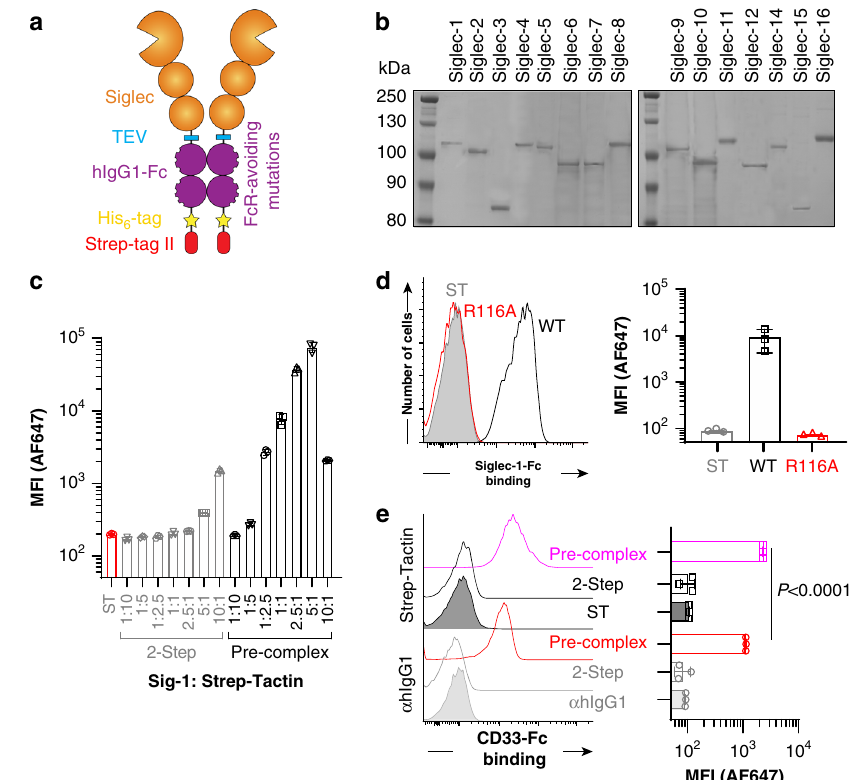
Fig. 1 Production and validation of new Siglec-Fc proteins. a Depiction of molecular features built into the new Siglec-Fc construct. b Coomassie-stained SDS-PAGE gel of all Siglecs puri fi ed through a three-step Nickel, ST, and SEC column puri fi cation strategy. Results are representative of two independent sets of puri fi cations. c Different amounts of puri fi ed Siglec-1-Fc was incubated with U937 cells in either a two-step or a pre-complexed approach with a constant amount of Strep-Tactin-AF647. d Flow cytometry results for probing Siglec-1-Fc WT or Siglec-1-Fc R116A with U937 cells using the optimized pre-complexed conditions. e Flow cytometry results of probing CD33-Fc WT with U937 cells in a two-step assay or a pre-complexing assay with α hIgG1-AF647 or Strep- Tactin-AF647. Error bars represent±standard deviation of three replicates. Statistical signi fi cance calculated based on a two-tailed unpaired Student ’ s t